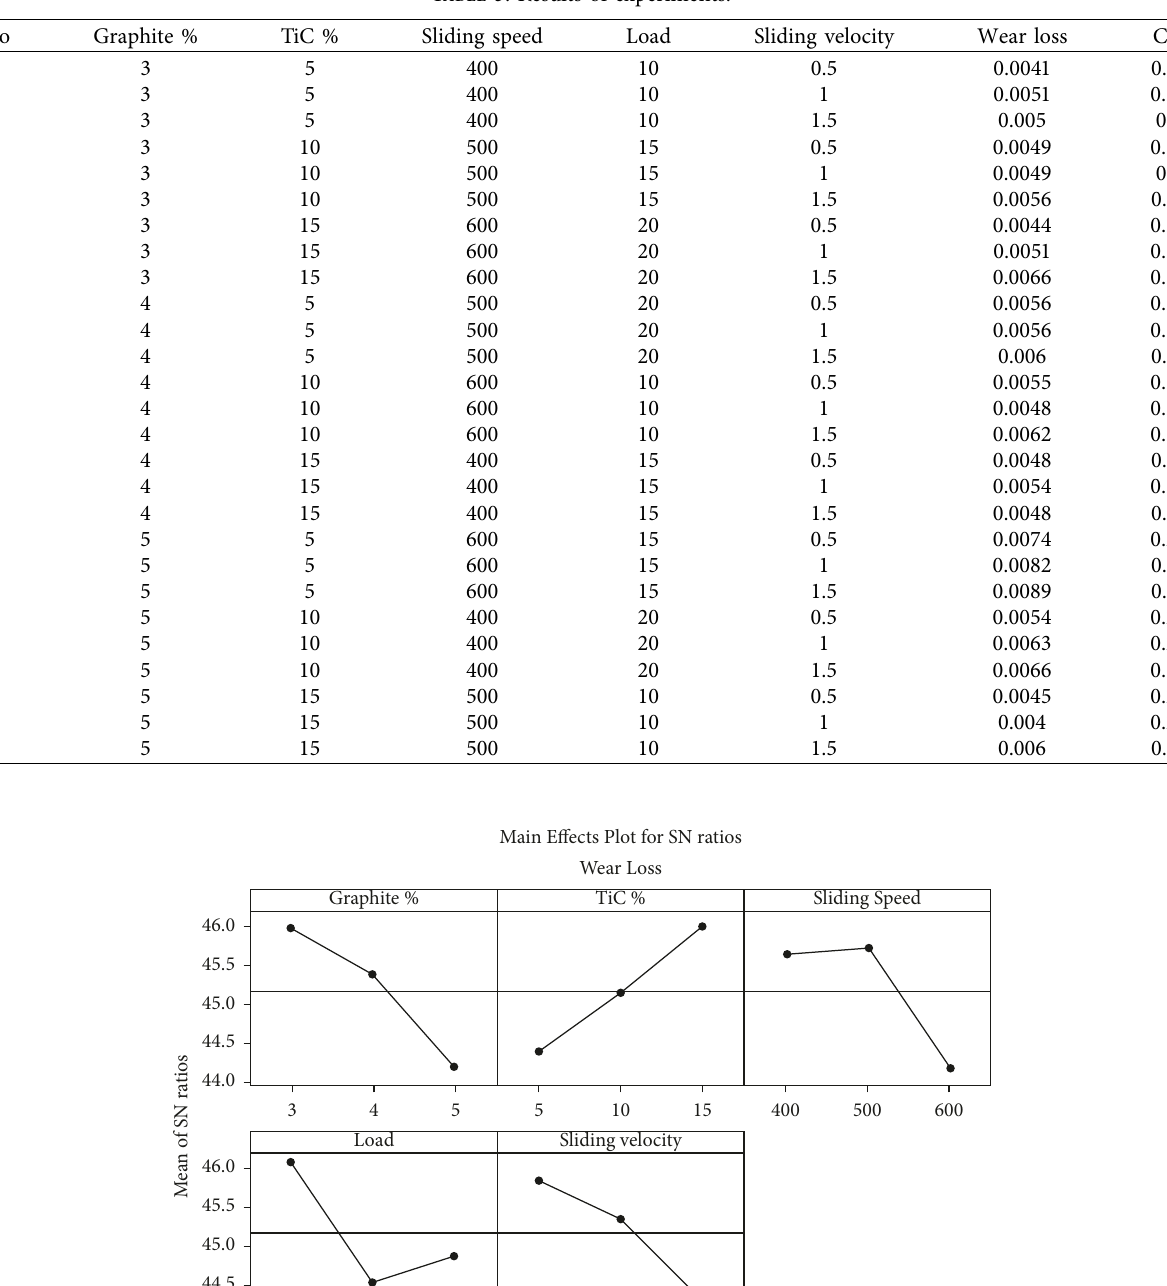
Table 3: Results of experiments.